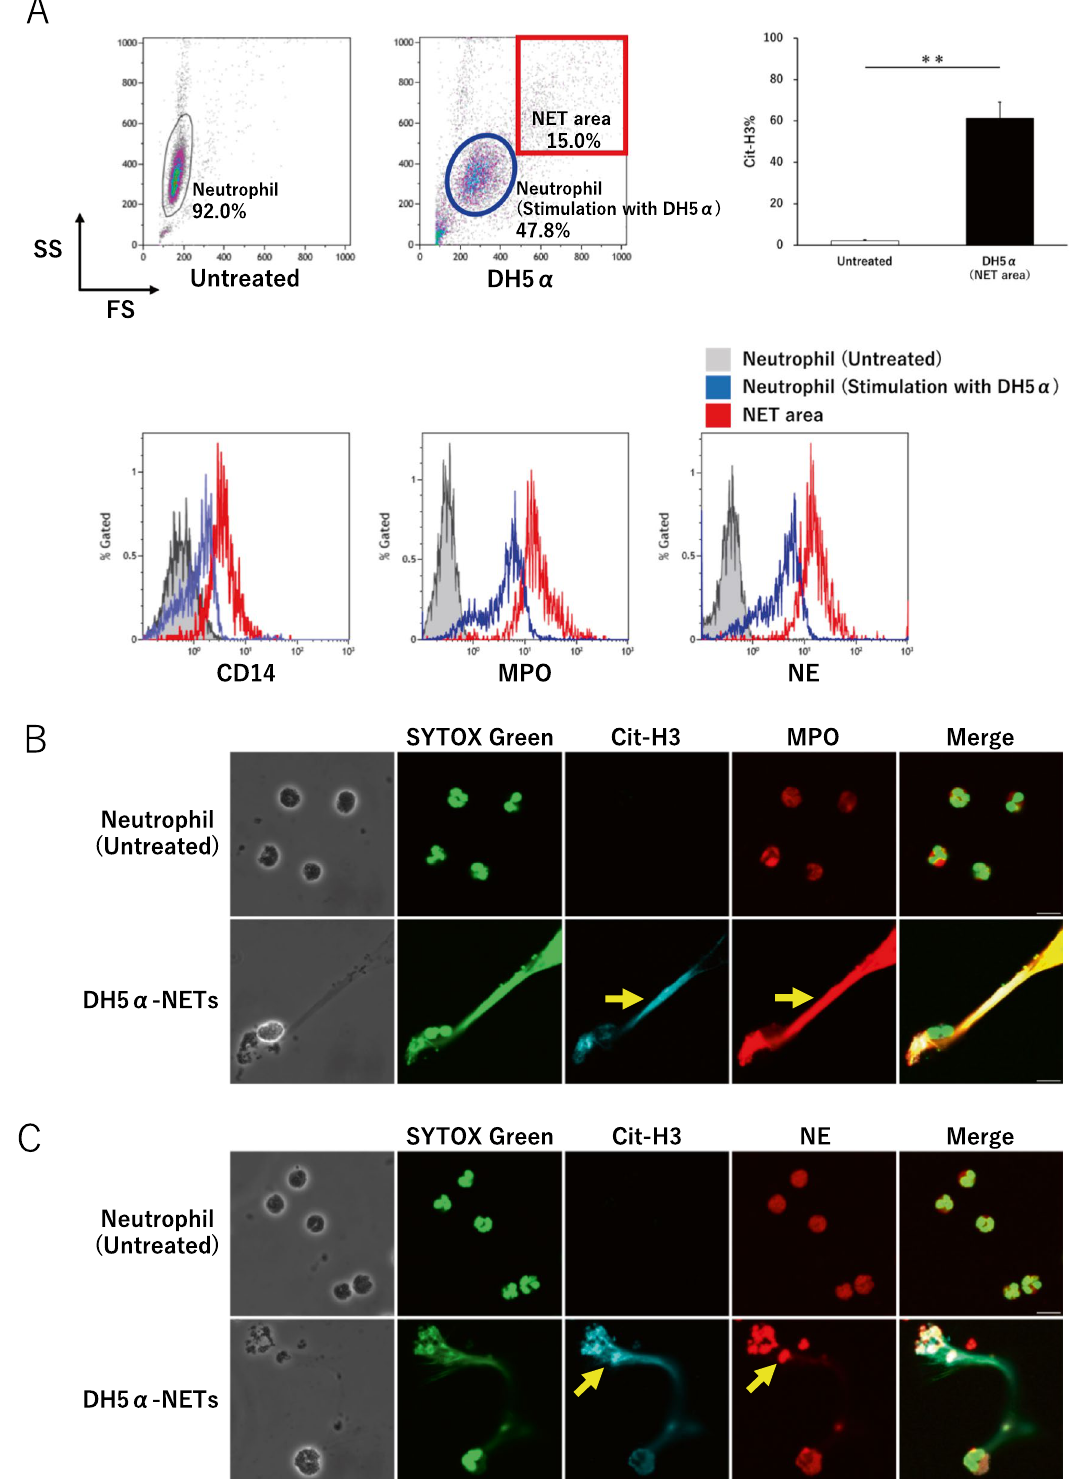
Figure 2. NETs stimulated with DH5α express high levels of CD14, MPO, and NE. ( A ) Cit-H3 positivity rates in Untreated and the NET area were measured by flow cytometry and compared. The NET area highly expressed CD14, MPO, and NE than the untreated neutrophils, as shown by flow cytometry. ( B , C ) Scale bar: 10 μm. Extracellular MPO and NE expression in DH5α-NETs by immunofluorescence imaging. ( D ) CD14 expression in DH5α-NETs. Scale bar: 10